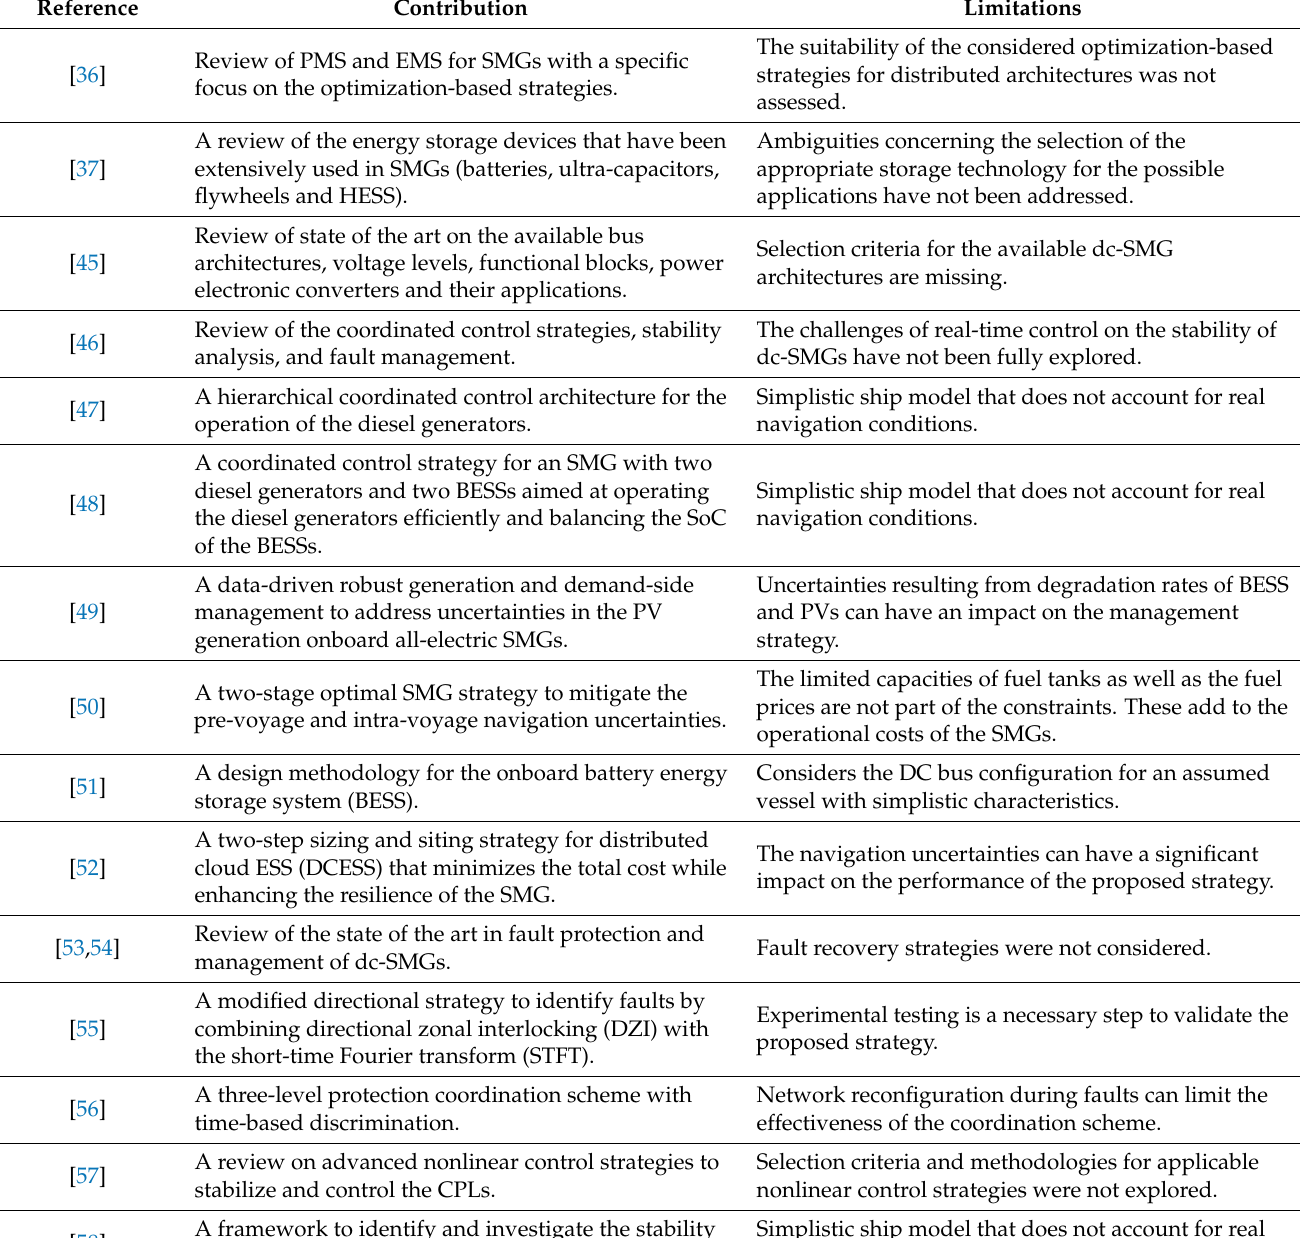
Table 3. Main contributions in recent literature focusing on